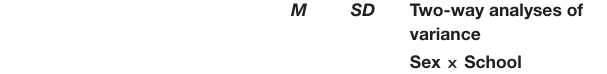
TABLE 5 | Opinions about the school computer courses/computer science